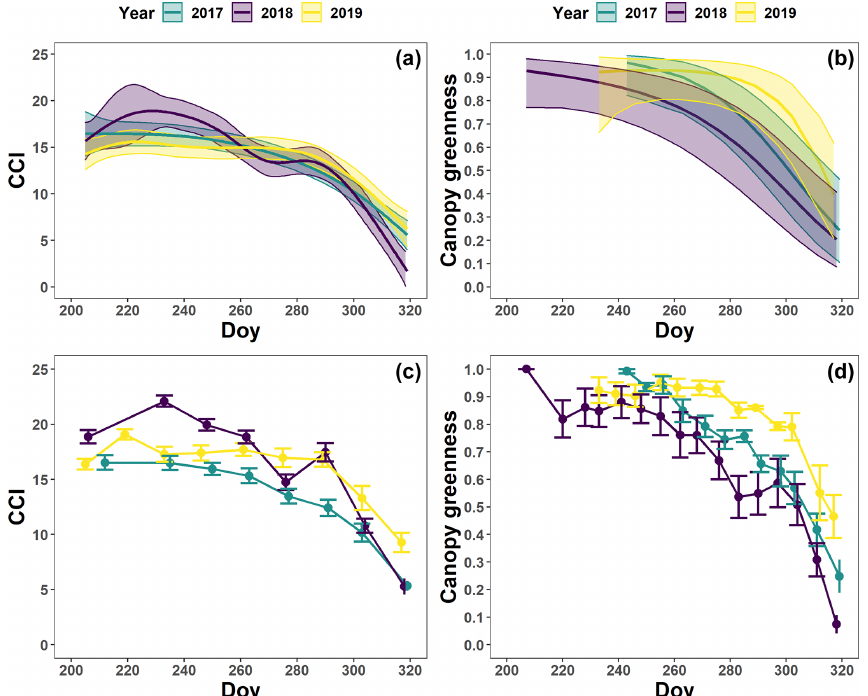
Figure 7. The generalized additive mixed model fits for the chlorophyll content index (CCI; n = 4; a ) and loss of canopy greenness ( n = 8; b ) of the mature Quercus robur trees at the Park of Brasschaat. The solid colored lines represent smooth terms, while the colored shaded bands around the smooth terms represent approximate 95% simultaneous confidence intervals (a) and 95% pointwise confidence intervals (b) . The dots and error bars represent the mean CCI (c) and mean canopy greenness (d) with standard errors. The colors represent the CCI or the loss of canopy greenness of the mature oak trees in 2017 (green), 2018 (purple) and 2019